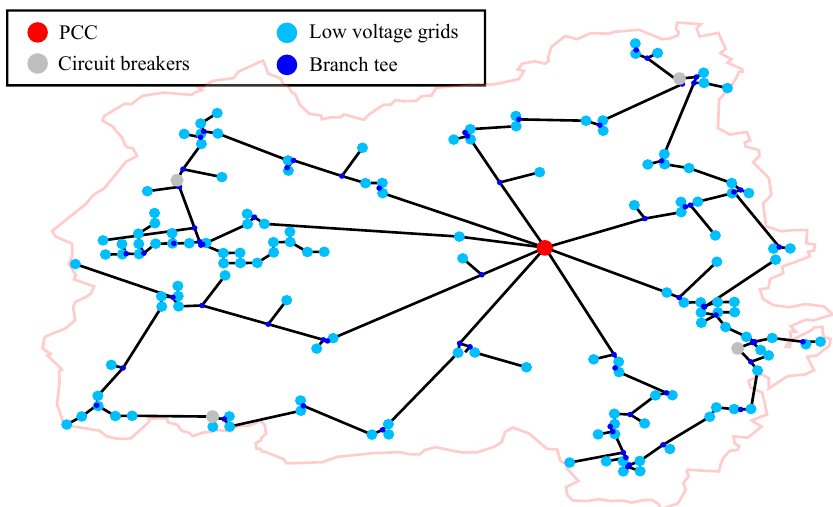
Figure 3. Graphical representation of the test distribution grid. The open circuit breakers are marked in gray, the MV/LV transformers are marked in light blue, the PCC in red, and all branch tees in dark